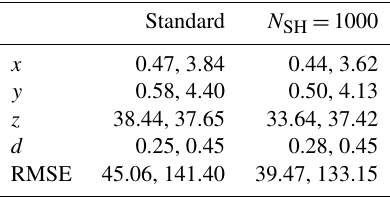
Table A4. The mean and standard deviation in the absolute error for each (x,y,z,d) , and RMSE, for evaluation on the test set of HOLODEC holograms. All reported values have units of